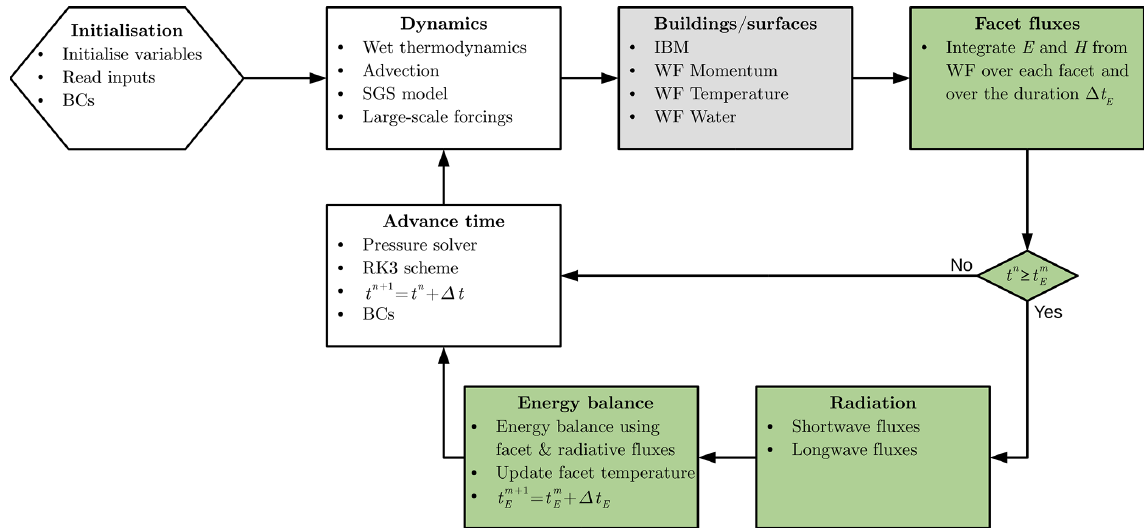
Figure 6. Schematic of the main routines in uDALES. Unshaded boxes refer to DALES core routines (see Heus et al., 2010). The grey box indicates the routines that are used when considering buildings. The green boxes refer to the energy balance routines